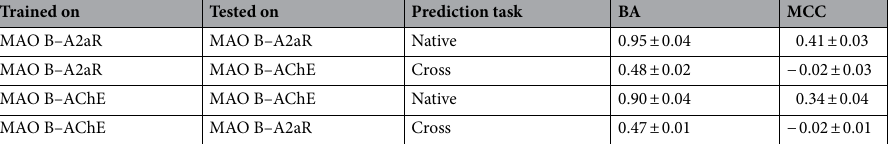
Trained on Tested on Prediction